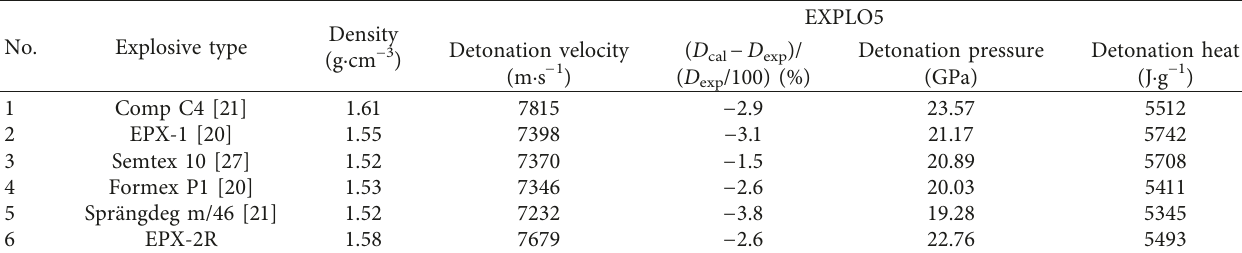
Table 3: The calculated detonation characteristics of the studied